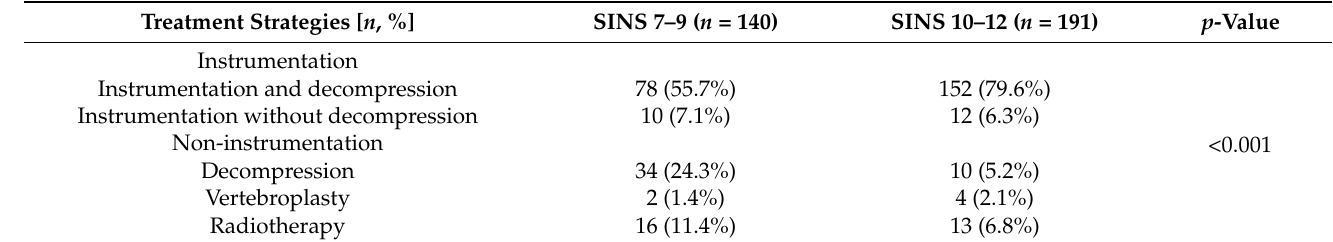
Table 5. Treatment strategies within the subgroups SINS 7–9 and SINS